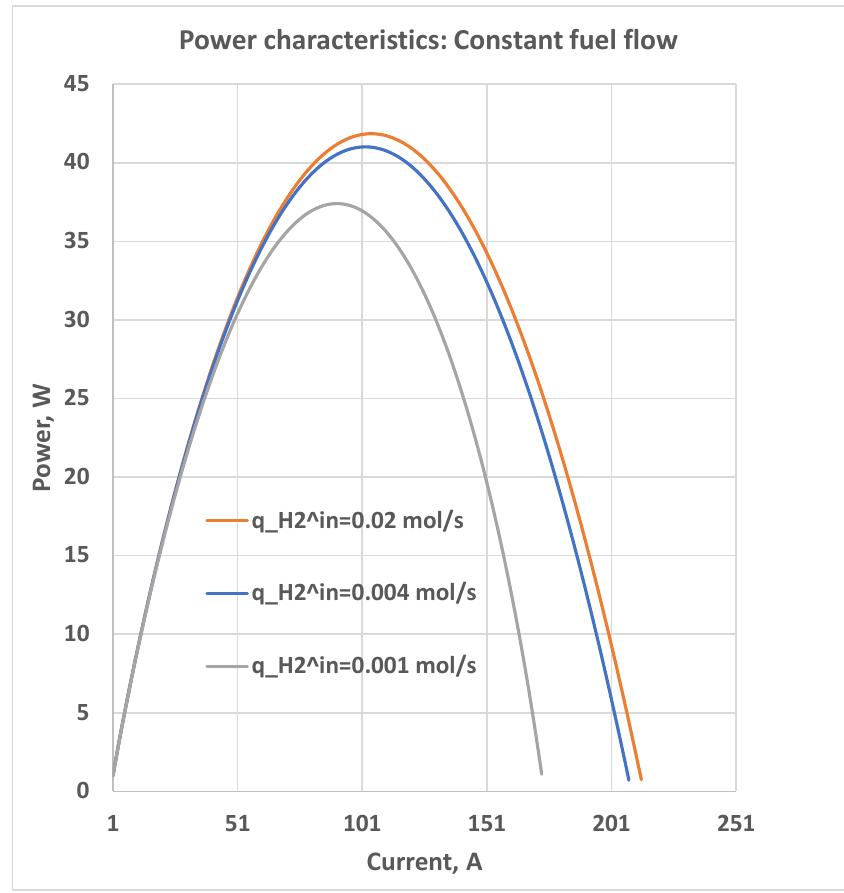
Figure 9. Power-versus-current behavior (both input flow rates are held constant, with the oxygen flow rate proportional to the hydrogen flow